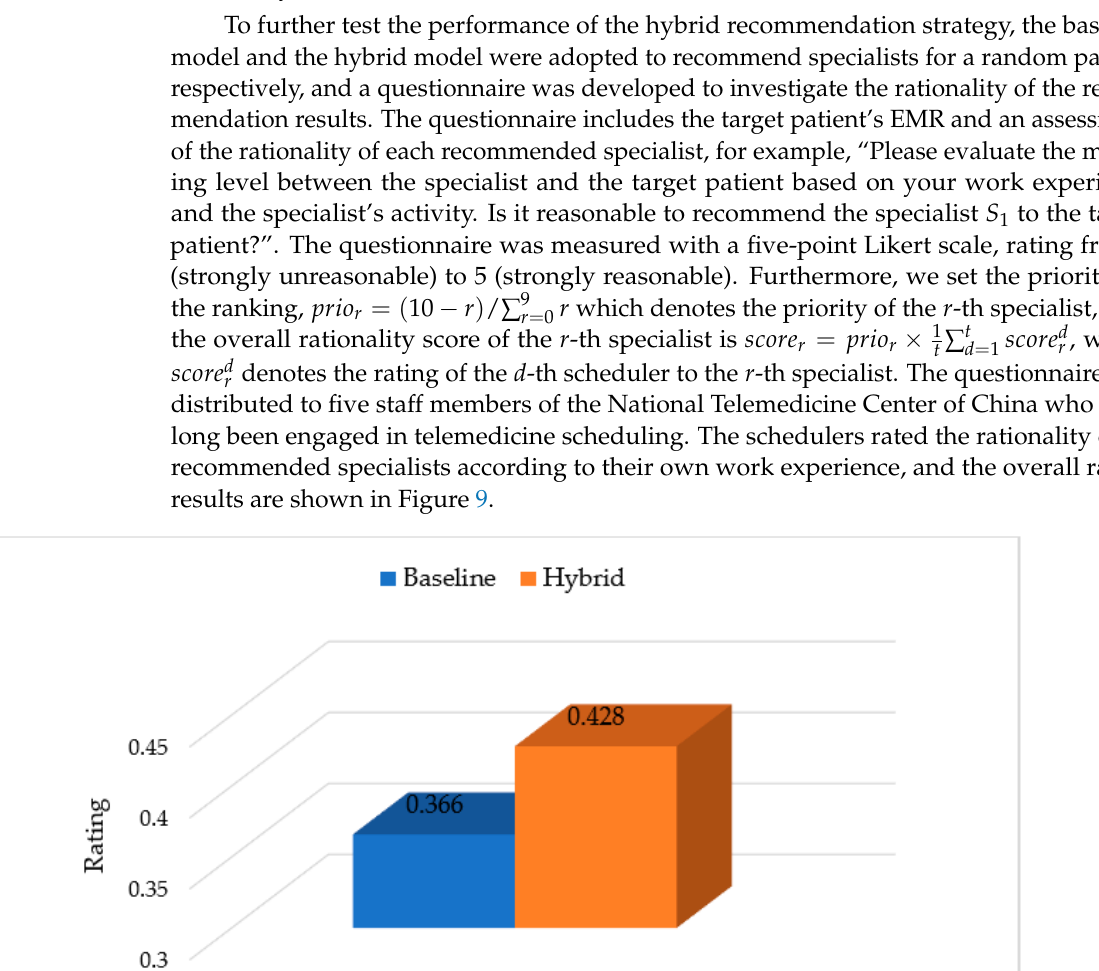
Figure 8. Comparison of Relevance and Activity.